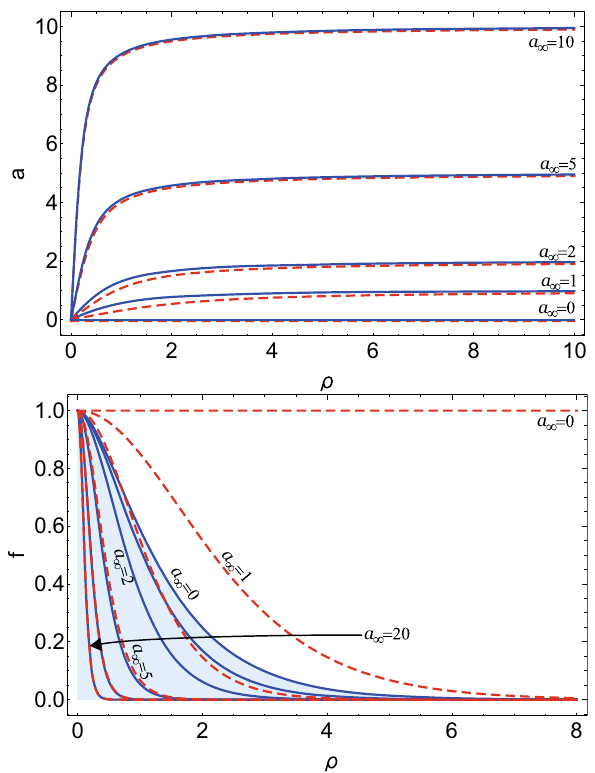
Fig. 9 The solutions a (top panel) and f (bottom panel) of the field equations (131) and (132) as functions of ρ . The broken lines are the profile functions (115) and (116) of the SD dyon as a constituent of the KvBLL caloron. The solid lines are the profile functions of the Yang– Mills dyon for various values of a ∞ from a ∞ = 0 to a ∞ → ∞ which covers the shaded region in the bottom